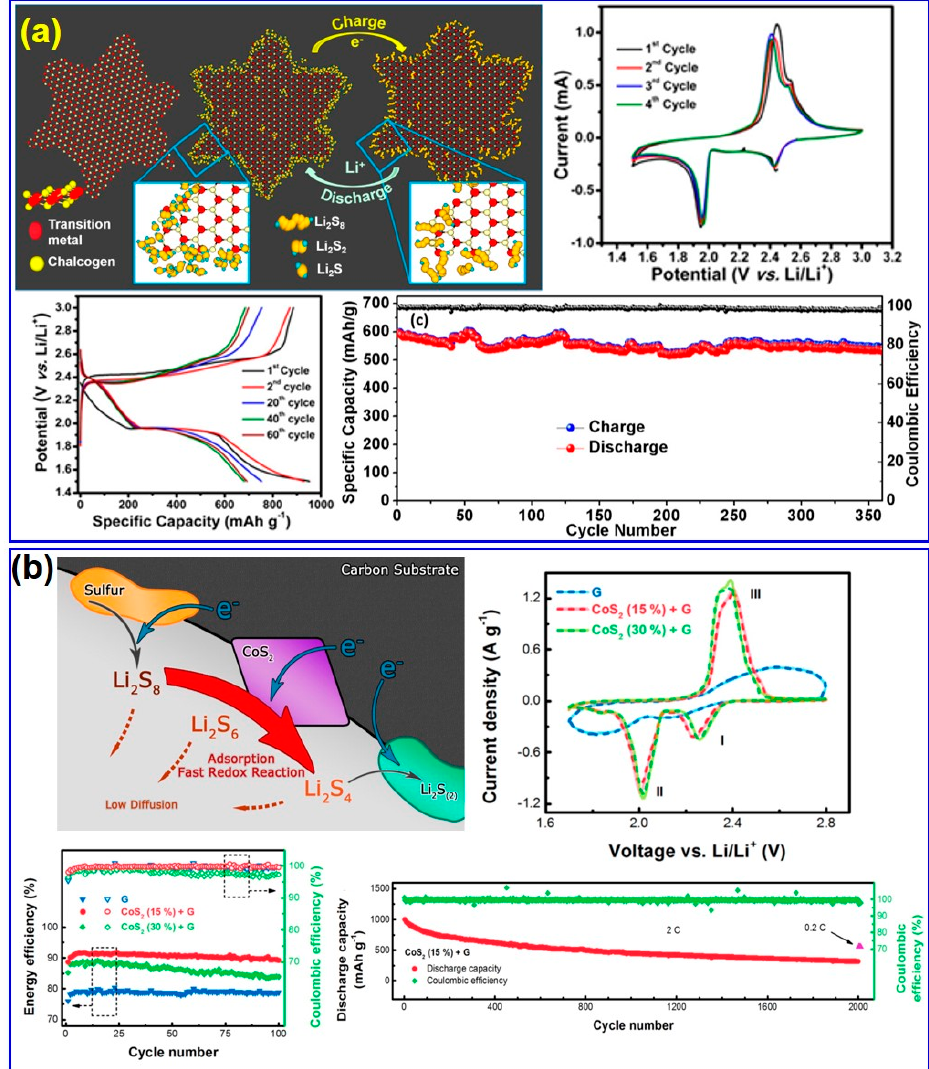
Figure 7. ( a ) Top left: Schematic representation of chemical vapor deposition (CVD)-grown atomically thin layered WS 2 nanosheets for Li-S batteries. Top right and bottom: Electrochemical studies of CVD-grown WS 2 nanosheets in Li-S batteries. Reproduced with permission, Copyright, 2016, American Chemical Society [62] . ( b ) Top left: schematic illustration of polysulfide conversion reaction using CoS 2 incorporated sulfur cathode. Top right and bottom: Cyclic voltammetry and cycling studies on the CoS 2 electrode. Reproduced with permission, Copyright, 2016, American Chemical Society [59] .